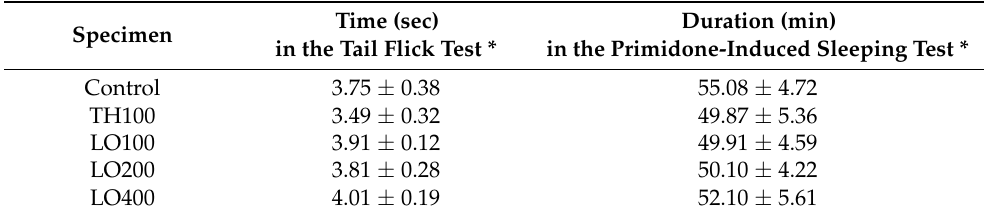
Table 4. Effect of different doses of C. osmophloeum ct. linalool leaf oil on antinociceptive and hypnotic activities in ICR